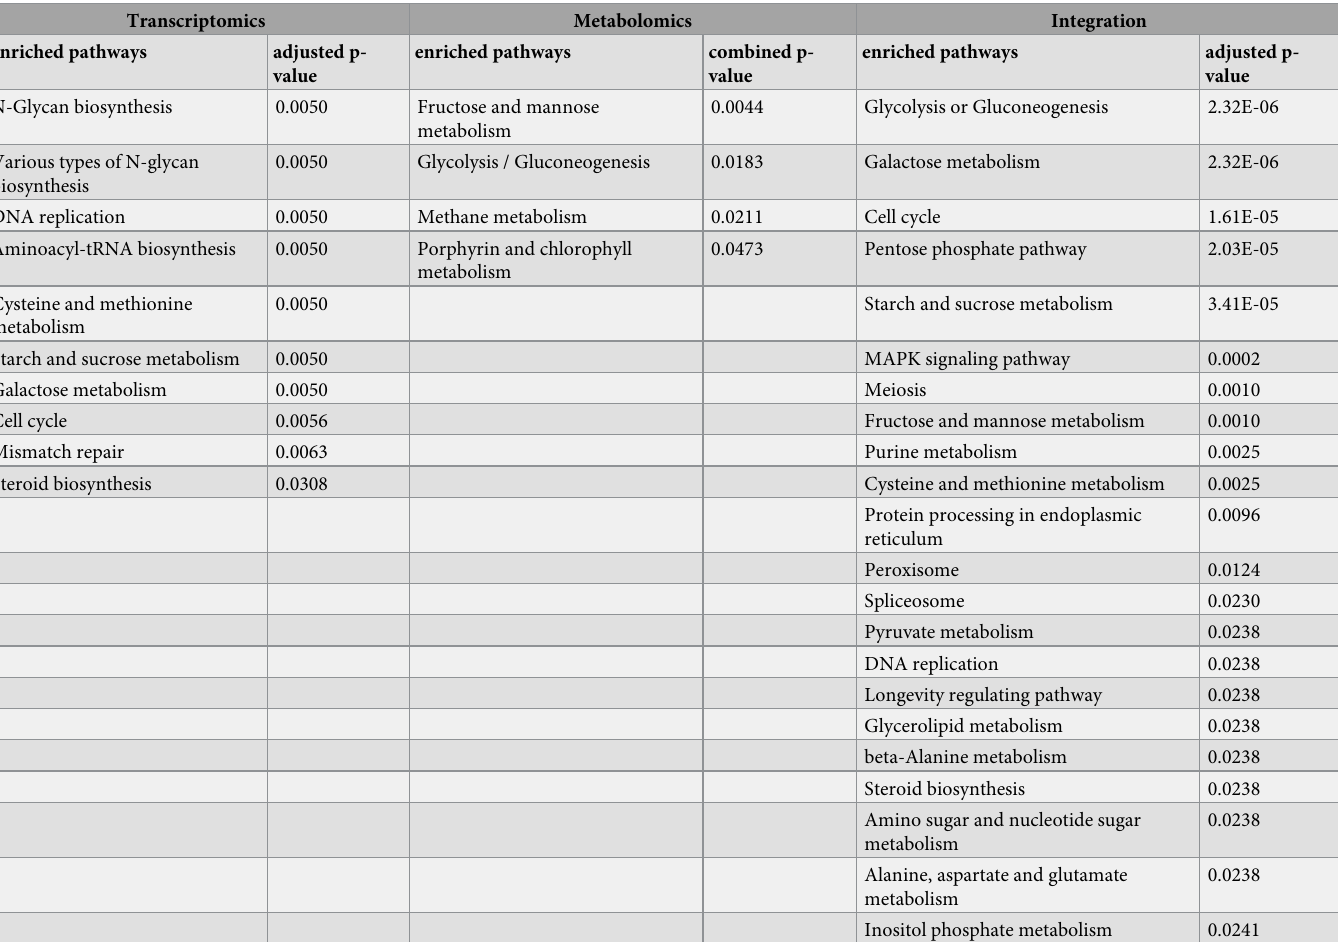
Table 4. Single- and Multi-omics integration results for gpa2 by sensitivity analysis. First block shows GSEA for transcriptomics with adjusted p-value < 0.05, arranged in ascending order; second block shows MetaboAnalystR pathway enrichment analysis for metabolomics with combined p-value < 0.05, arranged in ascending order; third block shows MetaboAnalystR joint pathway analysis with adjusted p-value < 0.05, arranged in ascending order, as detailed in